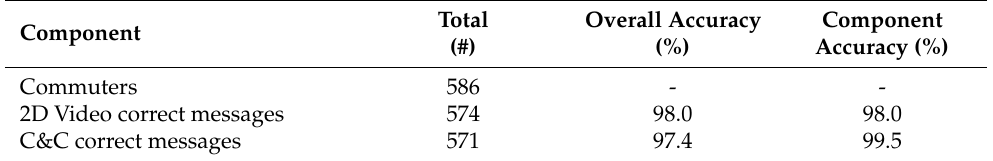
Table 2. Performance of the visualization pipeline.